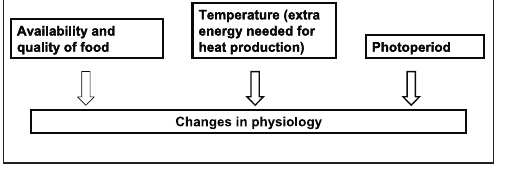
Fig. 1. Seasonal changes in photoperiod, temperature, and availability of food are the main environ- mental cues that through hormones induce the adaptive changes that enable the reindeer to sur- vive the winter.